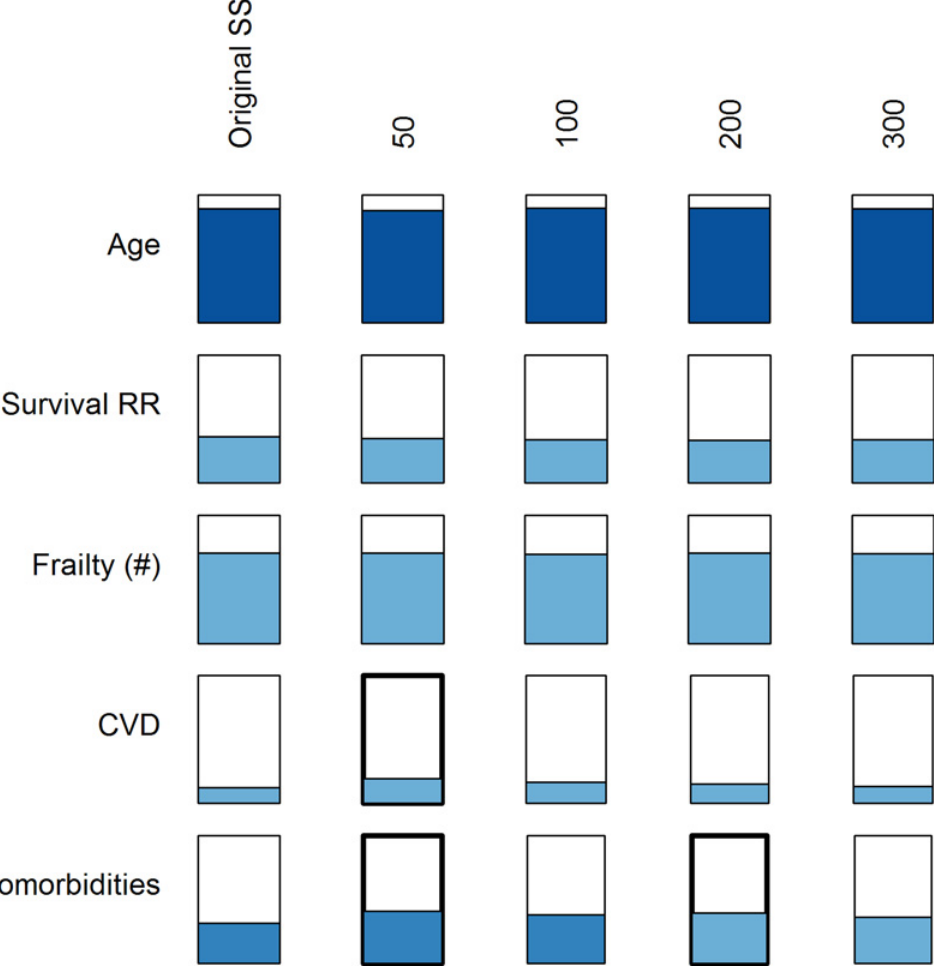
Fig 8. Effects of RP sample size on prediction of age and health outcomes. The study population represented here are individuals aged 20 – 70 from the InCHIANTI data set with RPs of various sample sizes drawn randomly from the study population. The width of the rectangle represents the average effect size among significant analyses, relative to the effect size of the rectangle in the leftmost column (entire study population as its own RP). The percentage of significant p-values is represented by the height of shading within the rectangle, the shading colour represents the direction of the effect (blue is a positive effect), and the hue represents the average p -value among the significant p-values, with darker hues indicating lower p